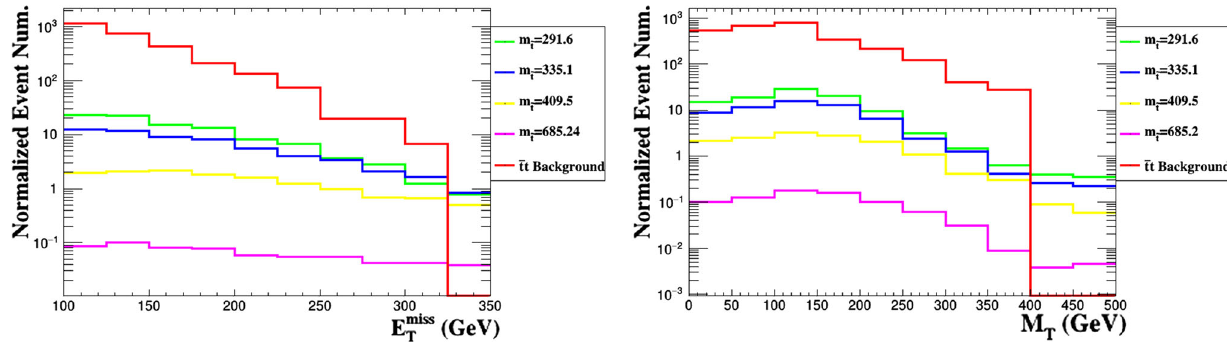
Fig. 7 Plots representing the E miss